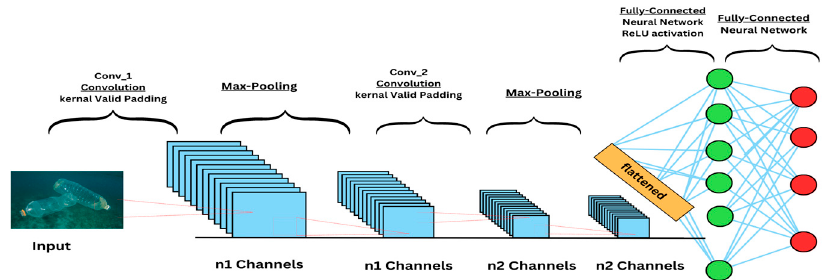
Figure 3. Overall design of the deep learning network utilized for prediction and waste